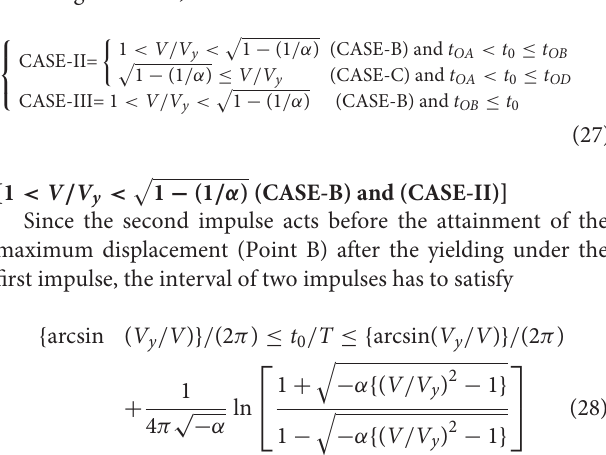
FIGURE 5 | Collapse pattern 2 ′ (CASE-B), (A) Restoring-force characteristic. (B) The collapse limit input velocity for α =